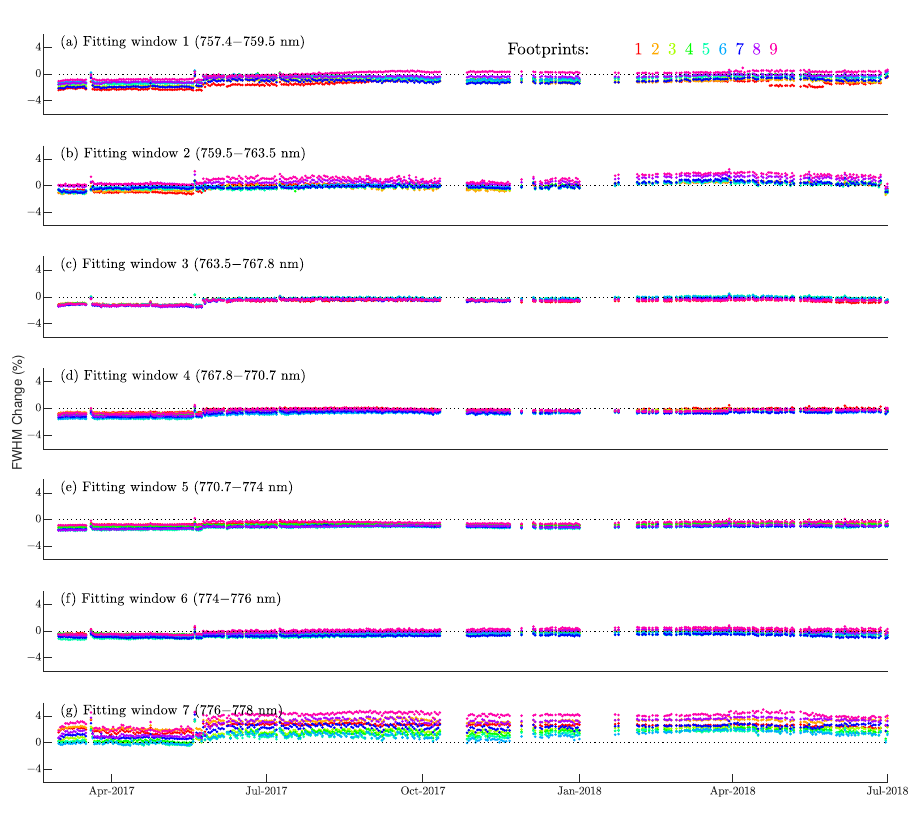
Figure 7. Variation in relative difference between FWHM derived using stretch/sharpen function and preflight FWHM in fitting windows at the O2A band for all footprints. Dotted line represents 0%. Figure 9 shows an example of the temporal variation in the sharpen term for the O2A and WCO2 bands. The sharpen term is generally less than 1, with values of 0.7–0.92 for the O2A band and 0.78–0.9 for the WCO2 band, indicating the widening wings of the derived ILS. The physical cause of the broadening wings may be related to the uncorrected stray